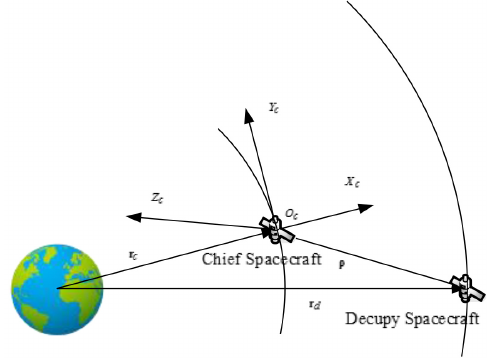
Figure 1. Illustration of example